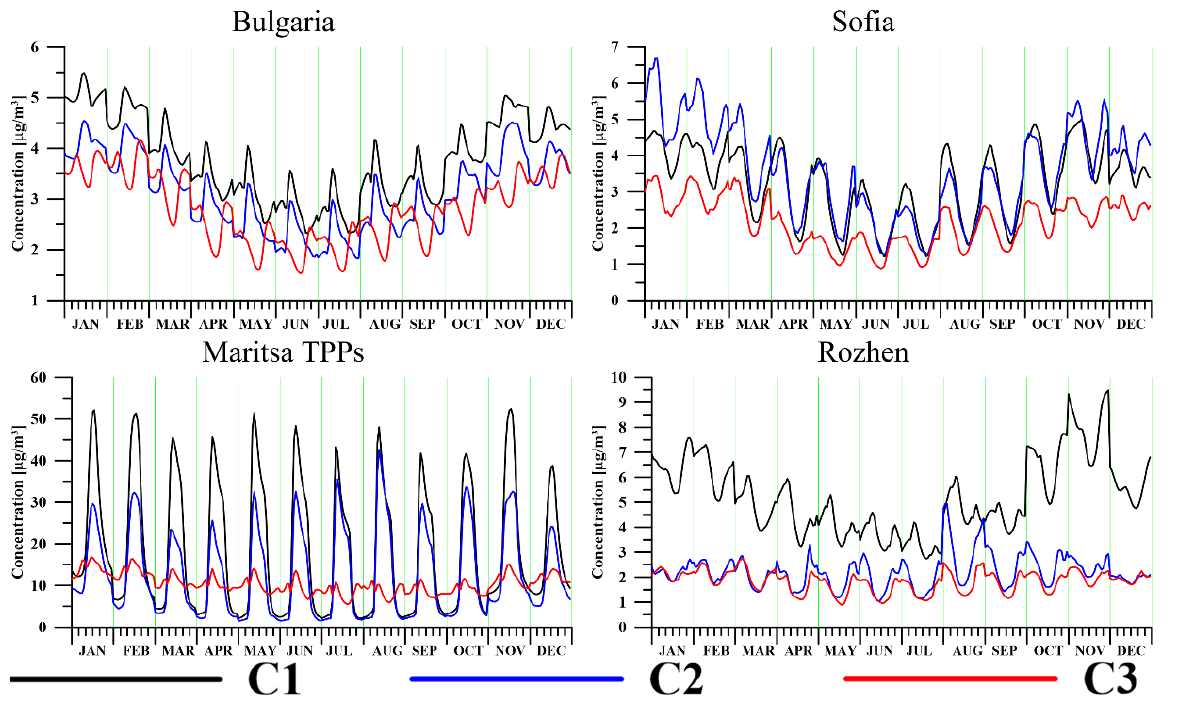
Figure 8. Diurnal and seasonal course of averaged over the ensemble surface concentrations of SO 2 [µg/m 3 ] for cases C1, C2 and C3.